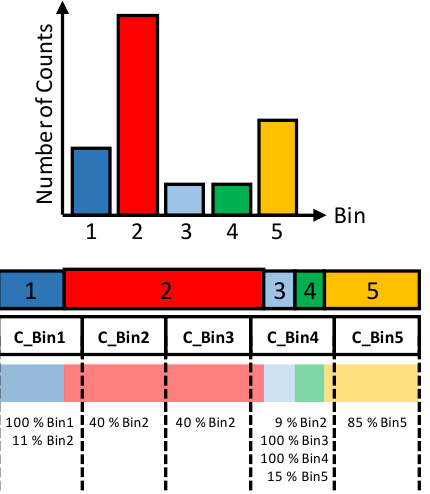
Figure 4. Average-bin-width calibration, redistribution of the total counts on identical calibrated